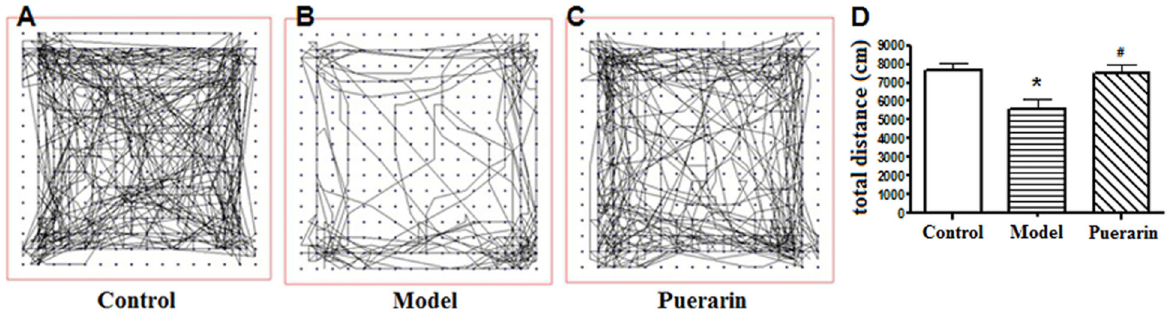
Figure 1. Results of the 30 min Tru Scan test. A - C , Spontaneous movement routes of mice in the control, model, and puerarin groups. D , Comparison of movement distance in 30 min among the 3 groups. *P , 0.05 vs control group; # P , 0.05 vs model group (one-way